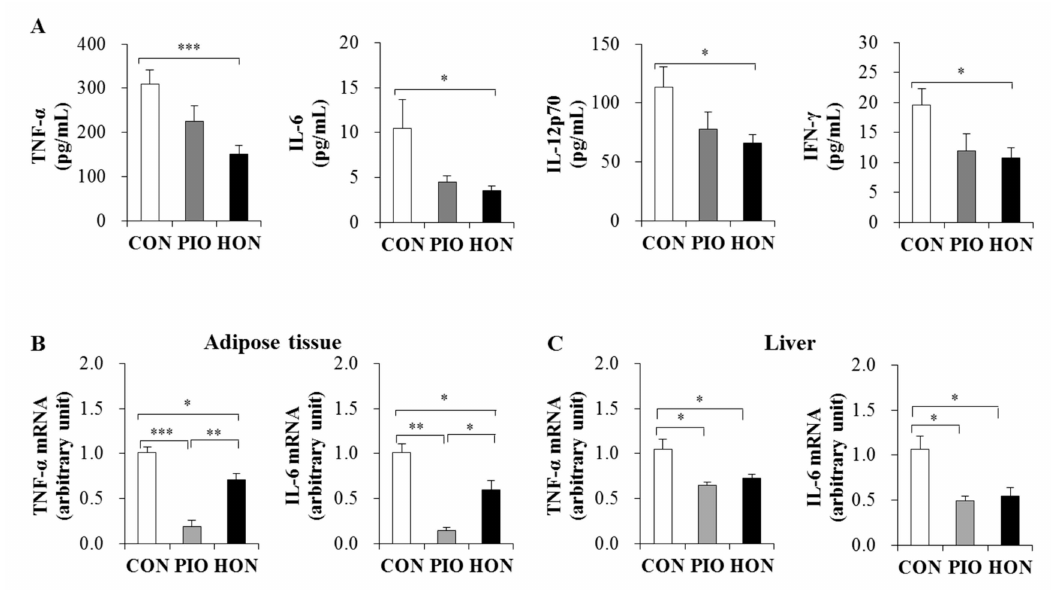
Figure 4. E ff ect of dietary HON on plasma pro-inflammatory cytokine levels ( A ), and the mRNA expression of pro-inflammatory cytokines in adipose tissue and livers ( B , C ) of db / db mice. Male C57BL / KsJ- db / db mice were fed a normal diet with or without HON (0.02%, w / w ) or PIO (0.01%, w / w ) for 5 weeks ( n = 10 per group). Data are presented as mean ± SE. * p < 0.05, ** p < 0.01, *** p < 0.001. CON; control group, PIO; pioglitazone, HON; honokiol, TNF- α ; tumor necrosis factor- α , IL-6; interleukin-6, IL-12p70; interleukin-12p70; IFN- γ ; interferon- γ